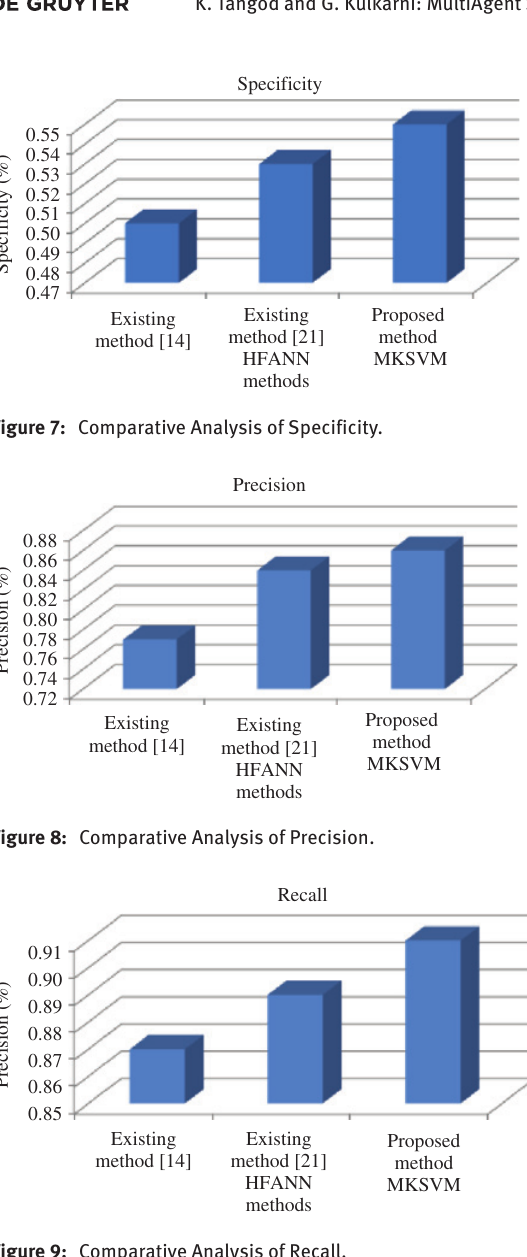
Figure 9: Comparative Analysis of Recall.